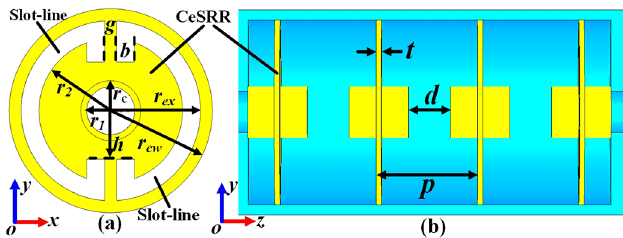
Fig. 3. (a) A CeSRR unit cell and (b) 3-gap MTM EIRC, where r 1 = 6.5mm, r 2 = 12mm, r ex = 16.5mm, r cw = 18.5mm, g = 2.6mm, b = 3mm, t =2.5 mm, and h = 9.5mm [48].